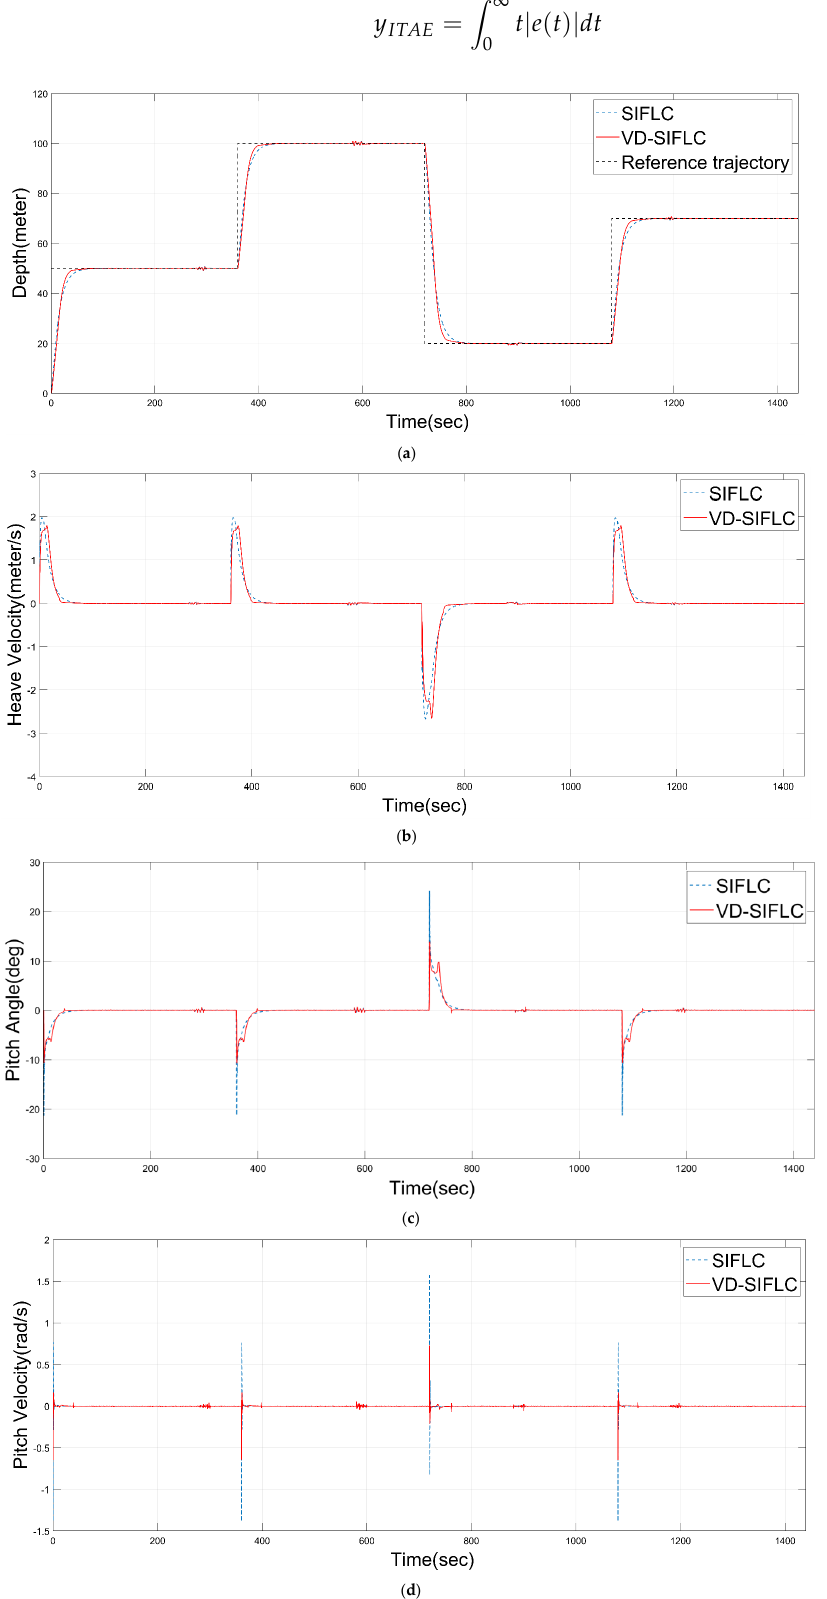
Figure 12. Variation of various parameters of VD-SIFLC and SILFC with time: ( a ) depth; ( b ) heave velocity; ( c ) pitch angle; ( d ) pitch velocity.